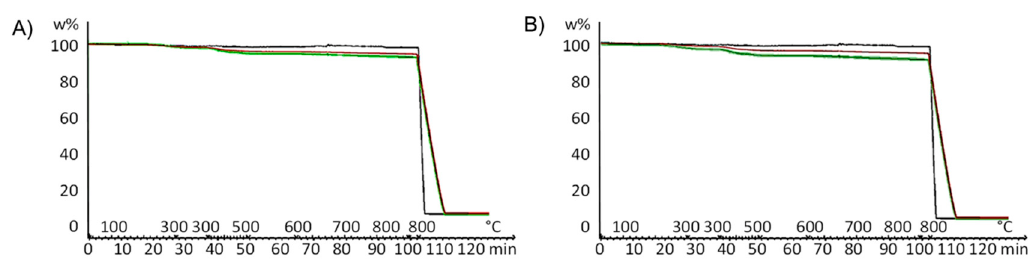
Figure 3. Thermogravimetric analysis (TGA) curves of: ( A ) single-wall carbon nanotubes (SWCNT) (black line), SWCNT / PPGP s (green line), and SWCNT c (red line); ( B ) multi-walled carbon nanotubes(MWCNT) (black line), MWCNT / PPGP s (green line), and MWCNT c (red line) .